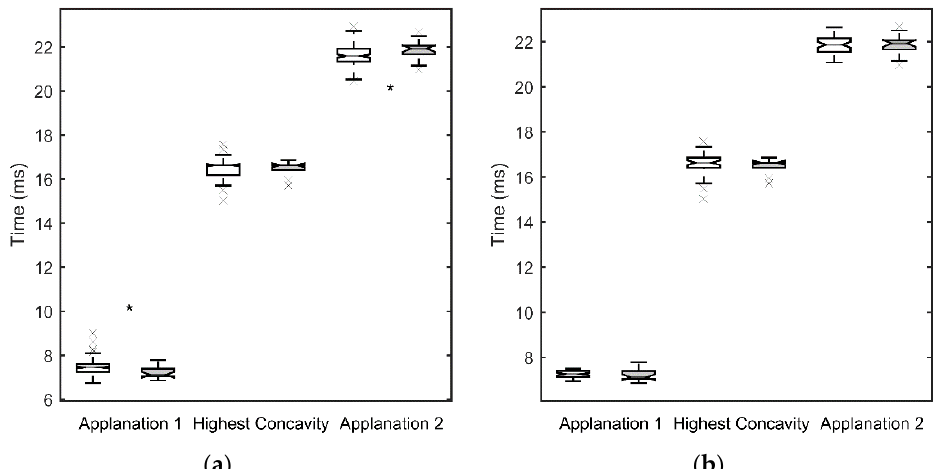
Figure 1. Time to reach first applanation, highest concavity and second applanation for the SCKC (grey) and control groups (white). The middle line of each box is the median of the distribution, the extremes are the first and third quartiles and the whiskers represent 1.5 times the interquartile distance; outliers are plotted with the symbol “x”. The notch represents de 95% confidence interval of the mean. “*” indicates statistically significant differences between groups ( p < 0.05) ( a ) whole control group, ( b ) IOP and CCT matched control group.